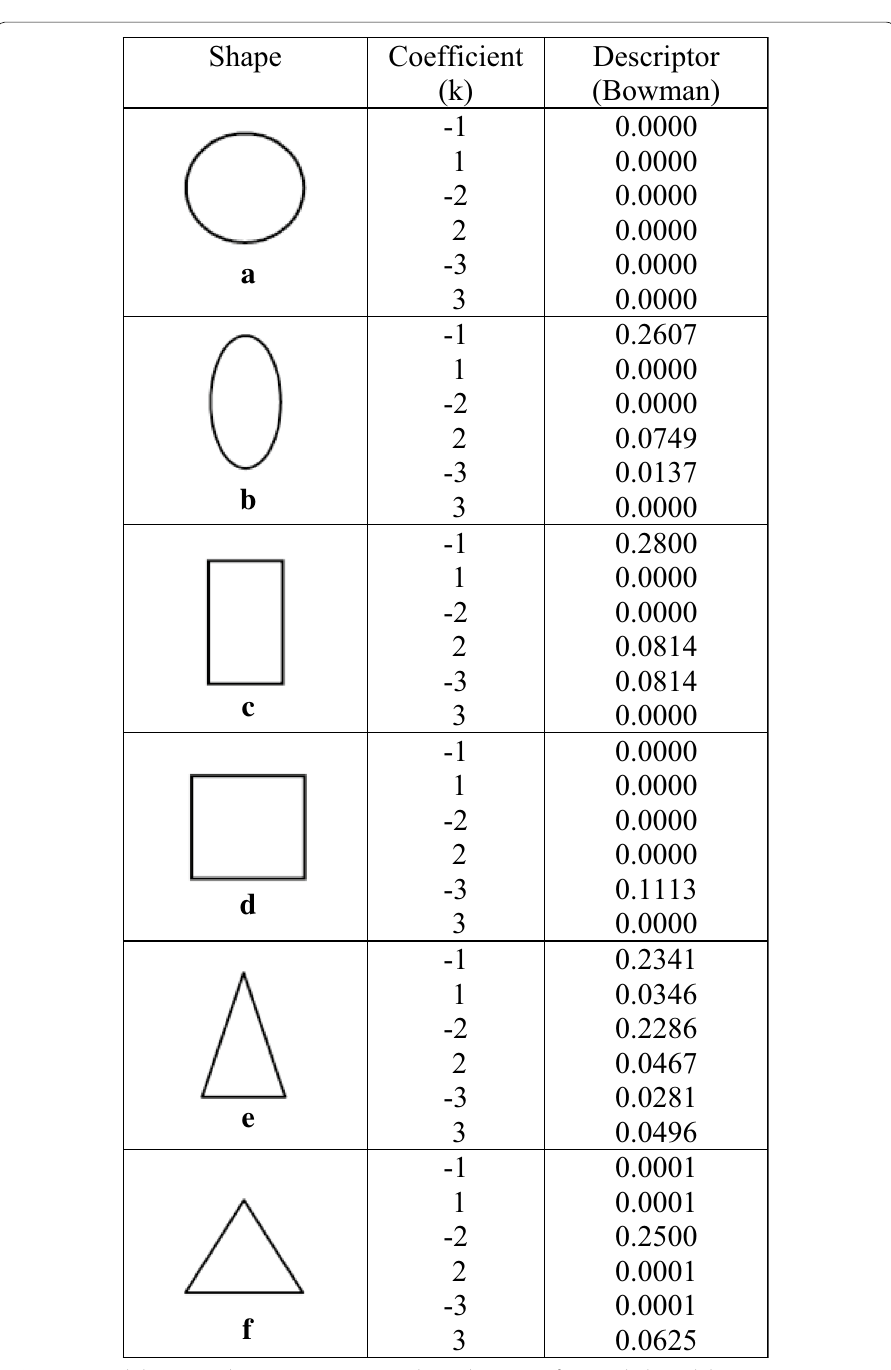
1 − 3 Second Order +